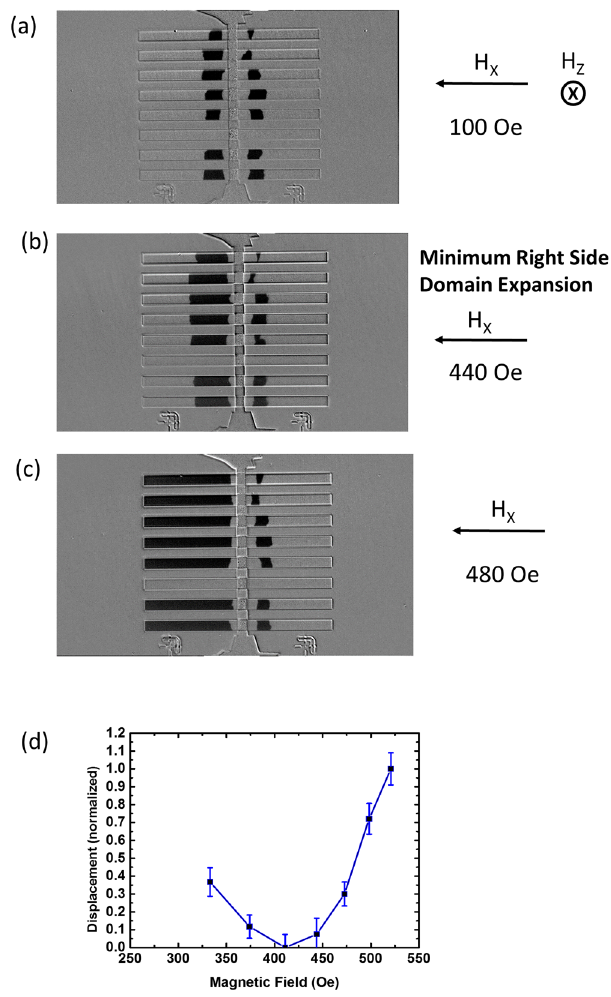
Figure 2. ( a – c ) Kerr imaging to show DW creep in the presence of out-of-plane and in-plane magnetic field. The in-plane field opposes DMI field for DW propagating towards right and minimum displacement occurs at field equal to DMI field. Here H DMI = 440 Oe. ( d ) Domain wall displacement as a function of in-plane magnetic